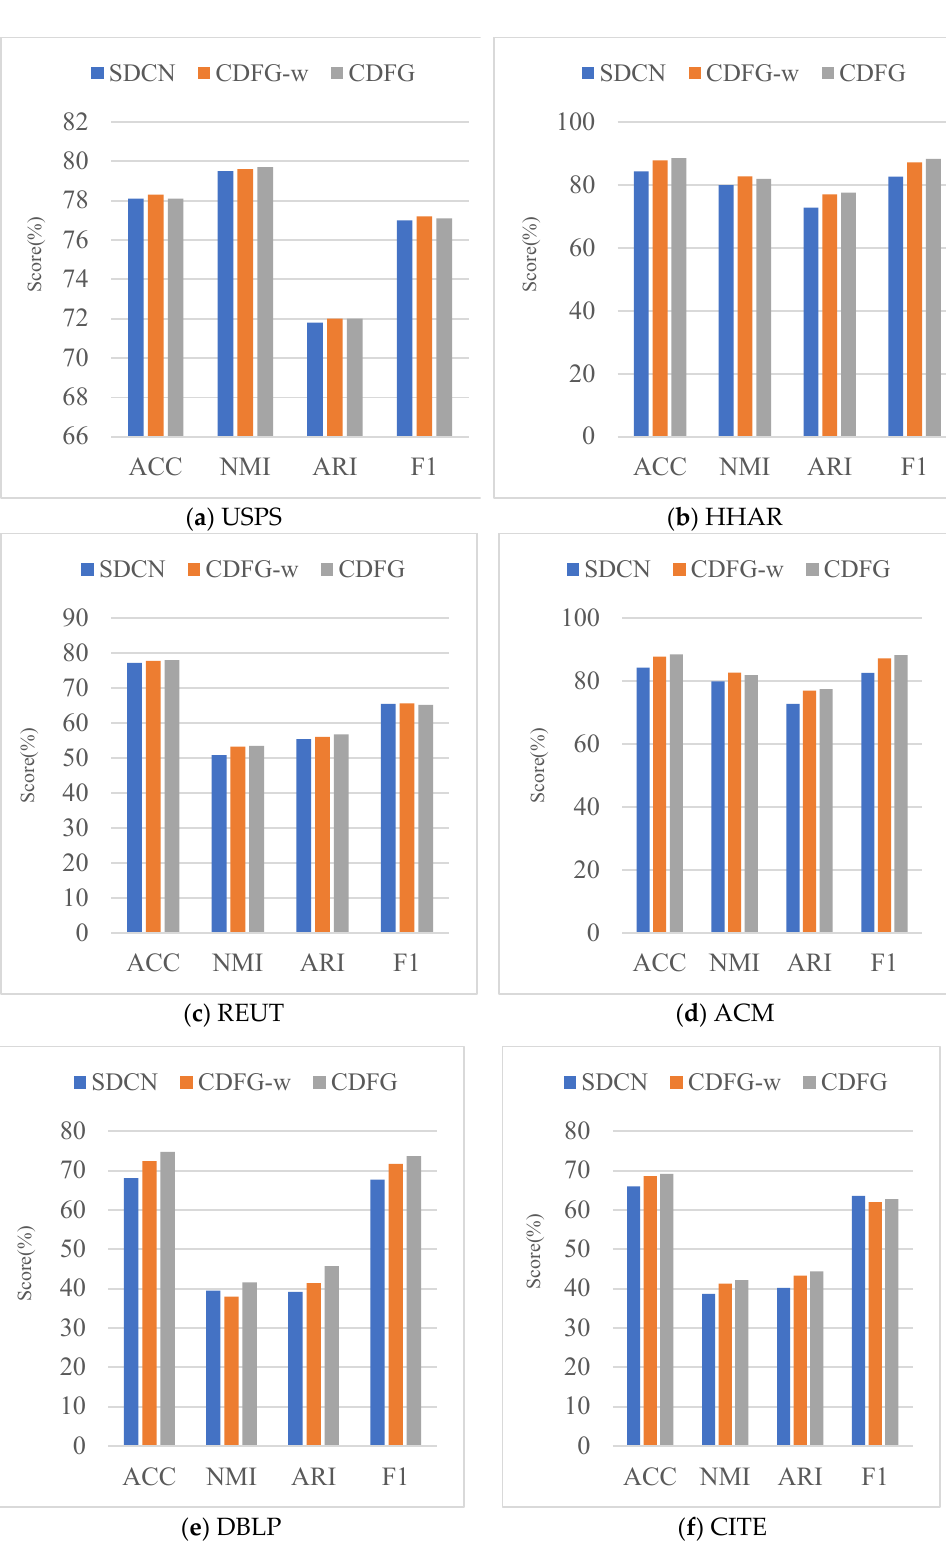
Figure 2. Comparison of experimental ablation effects of graph attention network module and feature fusion module. SDCN is the method using only graph convolution network and autoencoder. CDFG-w is the method with the addition of a graph attention network module. CDFG is the method with the addition of a feature fusion module.